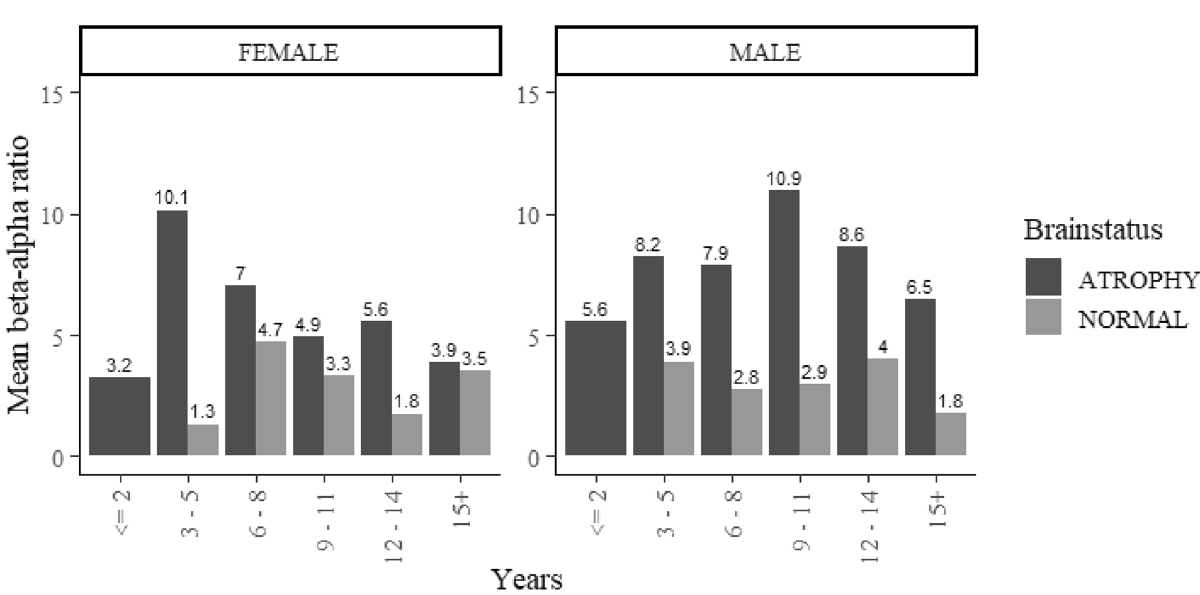
Figure 8. Varying trend of Focused Occipital BAR with gender. There is varying age in the peak values of the mean BAR with a constantly increasing trend in male children with brain